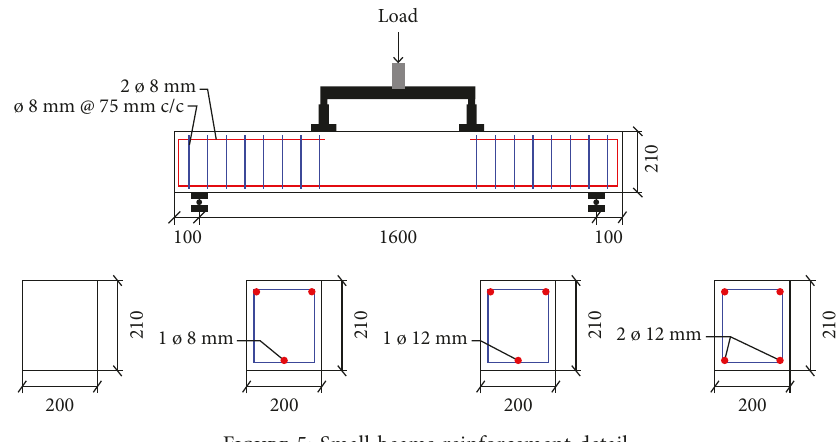
Figure 5: Small beams reinforcement detail.